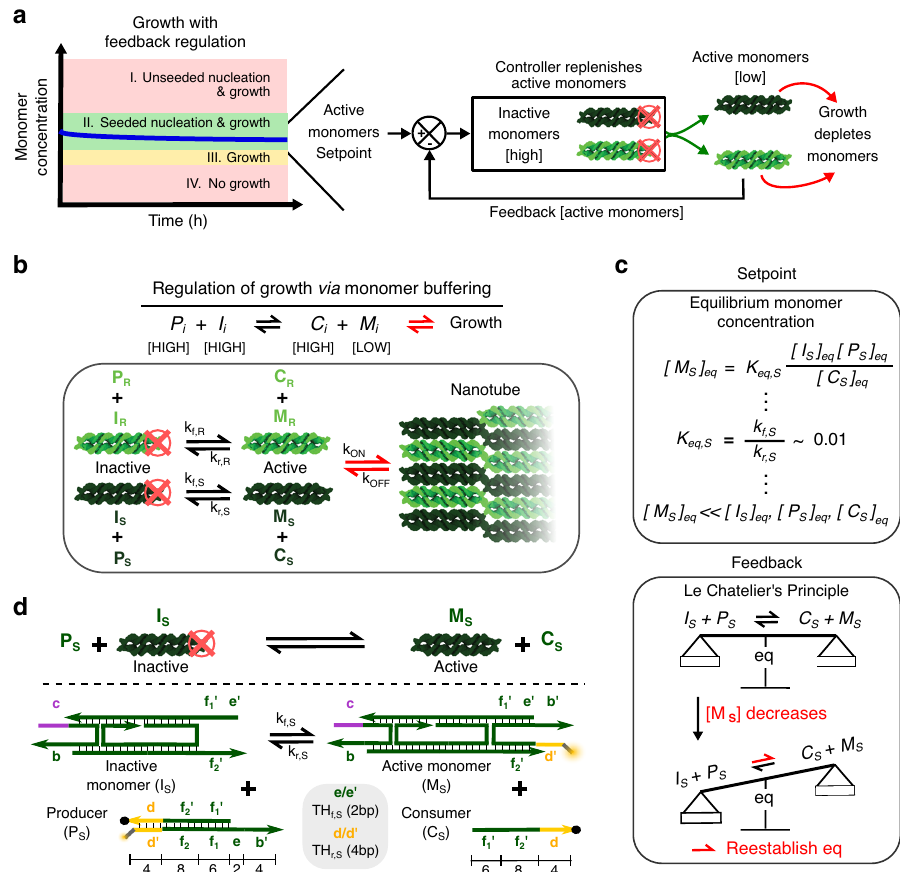
Fig. 3 Regulating nanotube growth by buffering monomer concentrations. a Schematic of a feedback controller for regulating growth. An ideal controller could maintain the monomer concentration within the seeded nucleation and growth regime by converting inactive monomers into active monomers as monomers are depleted by growth. b Overview of a scheme to regulate nanotube growth by buffering monomer concentrations via reversible conversion of monomers in inactive and active states. c Monomer buffering provides setpoint and feedback control. Top: The setpoint is determined by the equilibrium monomer concentration. A large concentration of I, P, and C can be used to regulate a low concentration of M. Bottom: Feedback is provided by Le Chatelier ’ s principle. As monomer concentration decreases during growth, the monomer buffering reaction will produce more active monomers to rebalance the forward and reverse reaction rates, thereby resisting a change in equilibrium. d A DNA strand displacement reaction network for buffering S monomer concentrations. An inactive monomer complex ( I S ) reacts with a Producer complex ( P S ) via a strand displacement reaction initiated by a single- stranded toehold domain (TH f, S ) to produce an active monomer ( M S ) and Consumer strand ( C S ). C S can react with an active monomer via another toehold domain (TH r, S ) to reverse the active monomer production reaction. Numbers indicate domain lengths in bases. An analogous network was also designed for the R monomers (Supplementary Fig.